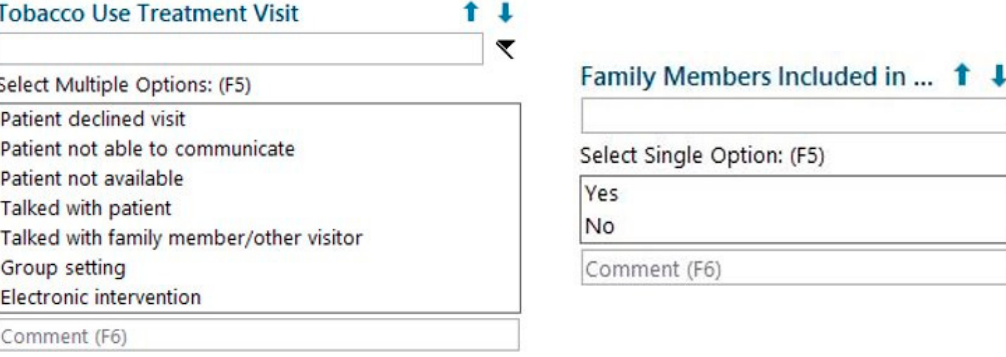
Figure 1. Fields added to the EHR documentation tool used by Tobacco Treatment Specialists (TTS). 83